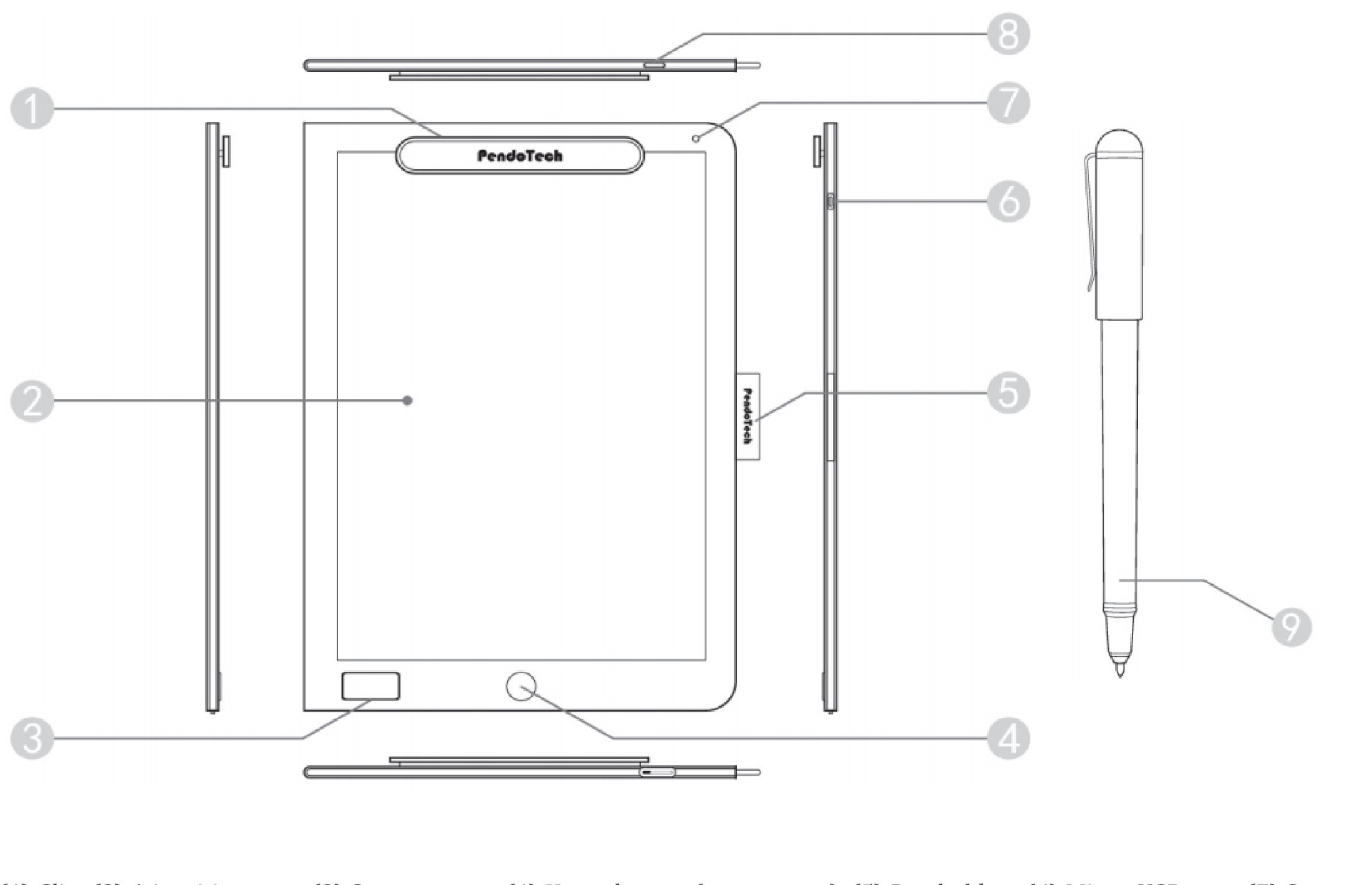
Fig 2. Digital handwriting tablet (Digit Note PH-1410, FCC ID: 2AI7G-PH1410) [25].